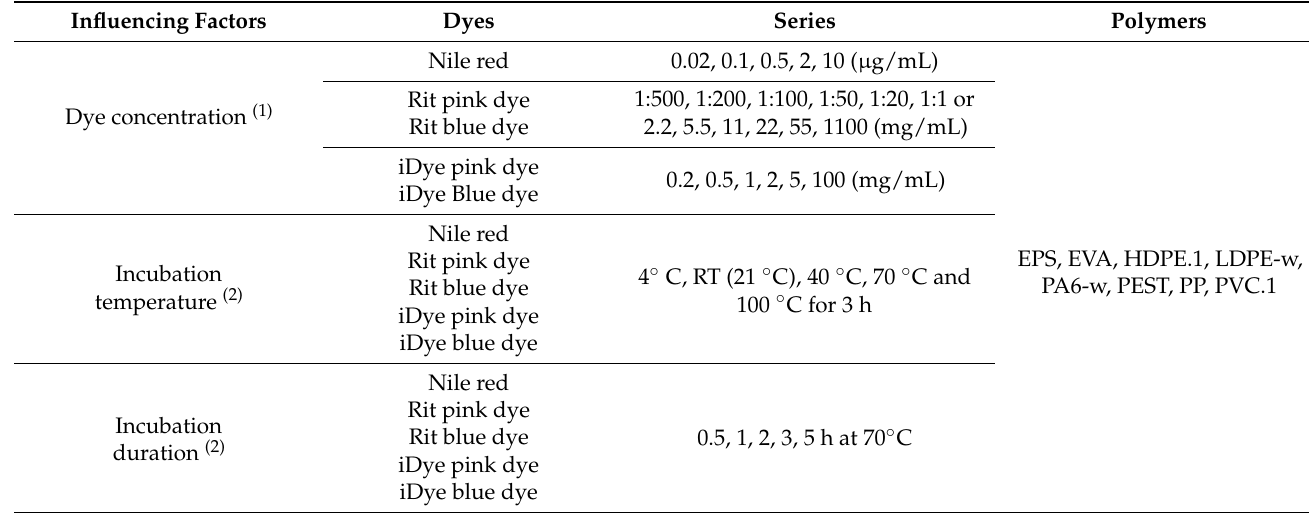
Table 1. The design of staining